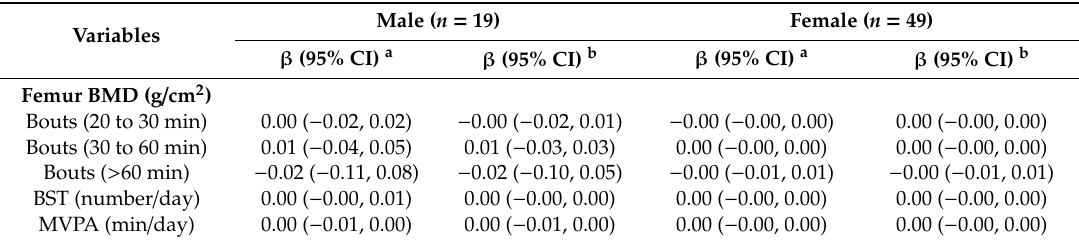
Table 4. Prospective associations of MVPA and sedentary patterns with BMD (mean changes) controlling for